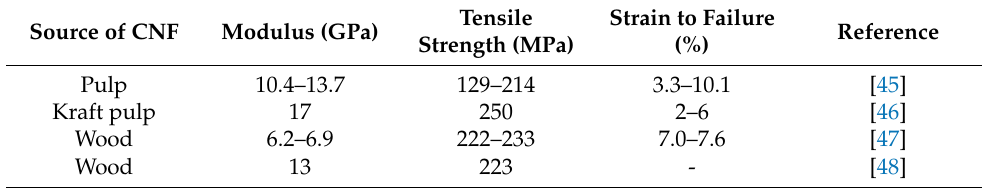
Table 2. Representative studies on the properties of CNF films from different raw materials.